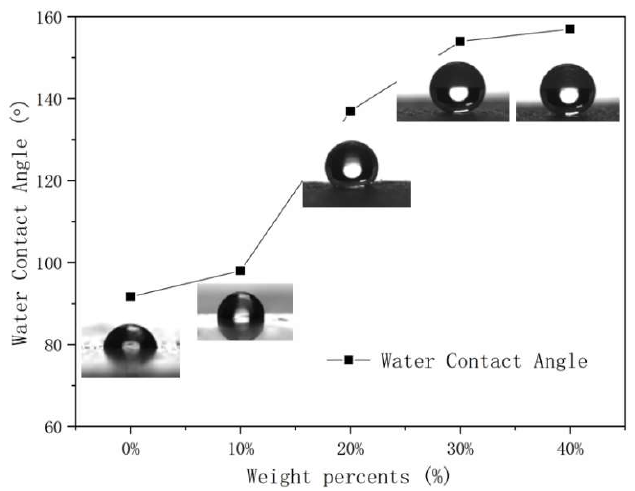
Figure 3. Water contact angle with respect to silica content by mass is illustrated for the aluminum sheets with hydrophobic coatings. The WCA increases with silica content, and photos of water droplets on hydrophobic surfaces with different silica content are shown accordingly.